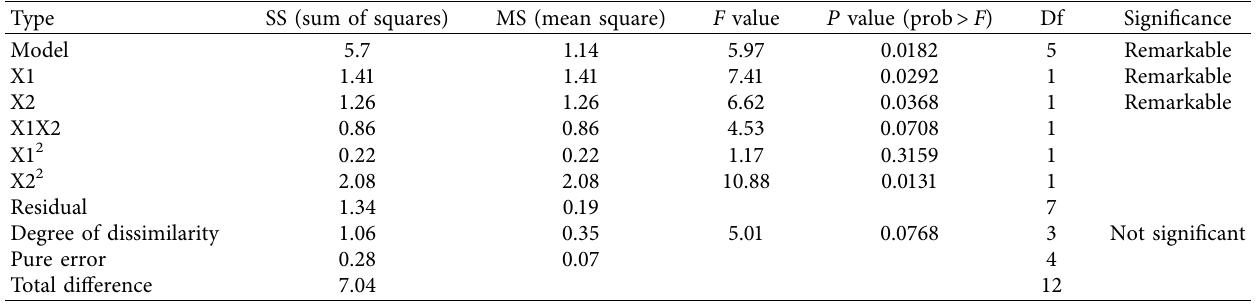
Figure 2: Contour plot of the effect of methanol ratio and column temperature on resolution. Table 3: CCD Analysis of variance.